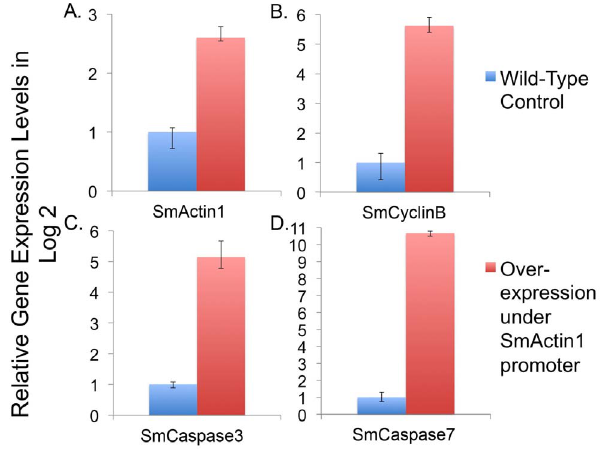
Figure 4. The SmActin1 promoter drives the overexpression of schistosome genes. Four endogenous schistosome genes (SmActin1 (A), SmCyclinB (B), SmCaspase 3 (C), and SmCaspase 7 (D)) were overexpressed from the SmActin1 promoter and compared to untransfected schistosomes (wild-type, negative control). The relative gene transcript levels are shown in log2.